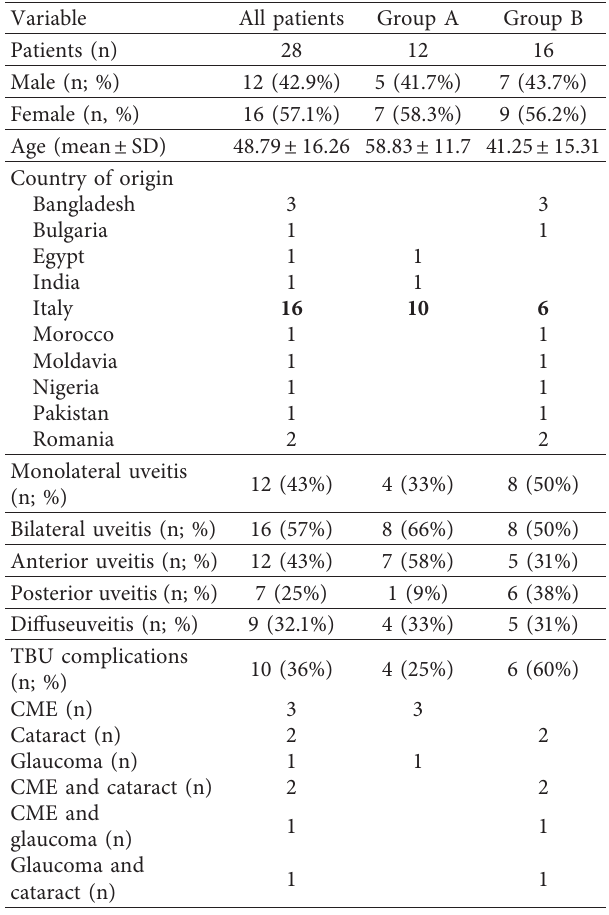
Table 1: Demographic characteristics, uveitis features, and ocular complications of the patients included in this